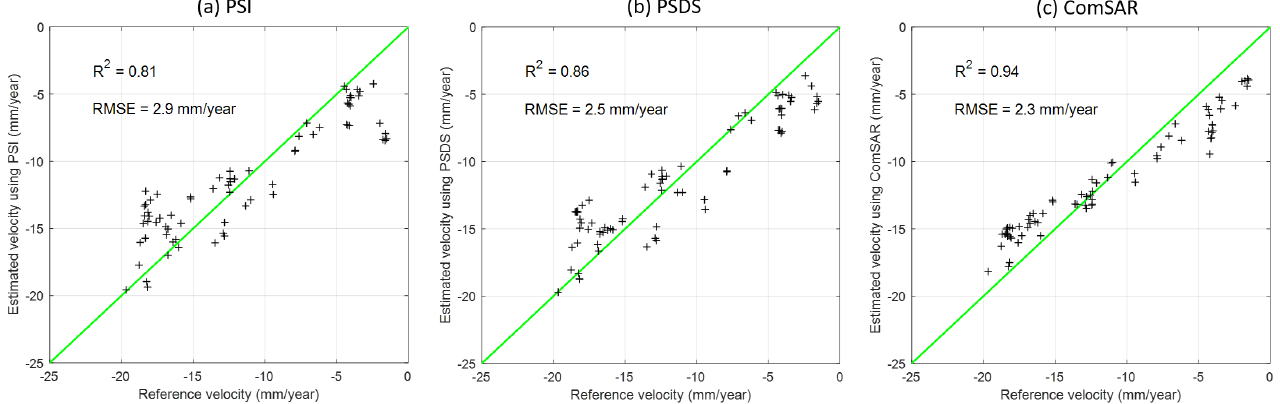
Figure 8. The cross-plot 1:1 velocity comparison. ( a ) estimated velocity using PSI; ( b ) estimated velocity using PSDS; ( c ) estimated velocity using